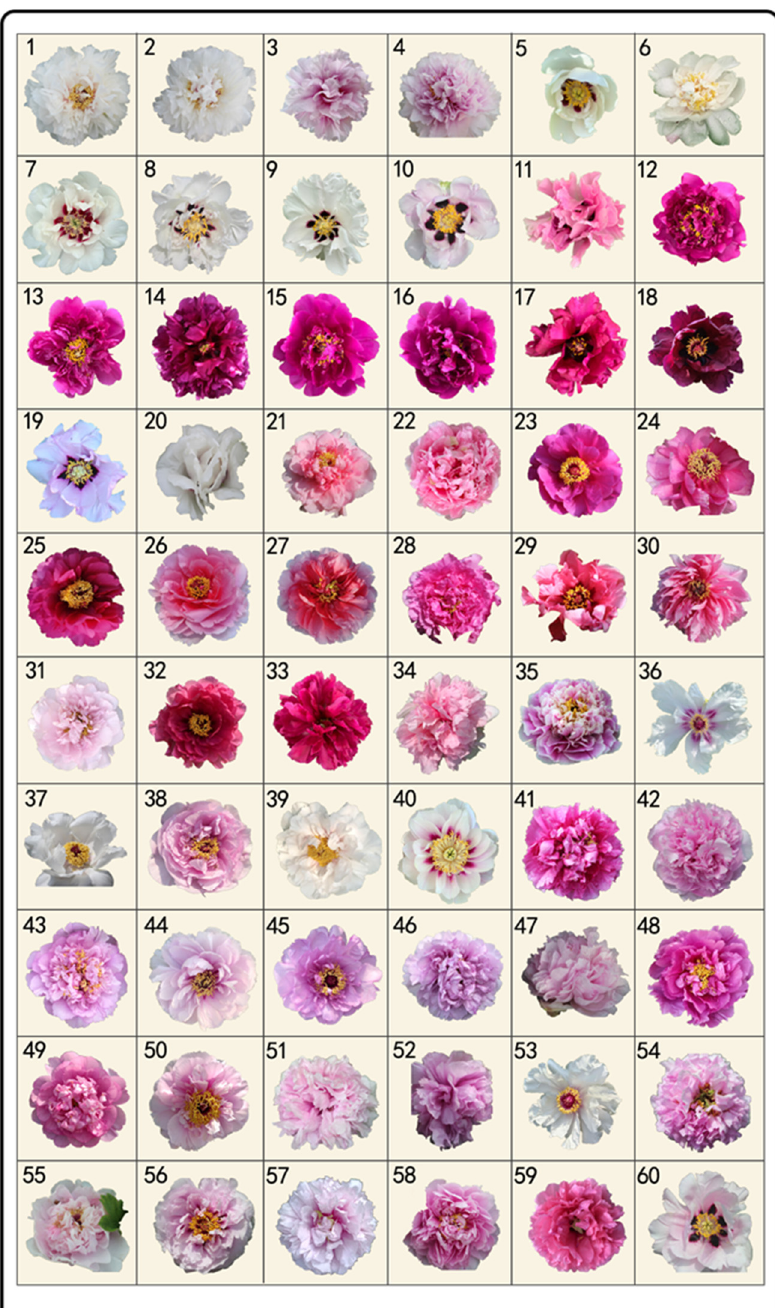
Figure 1. Flower photos showing the sixty tree peony cultivars used in this